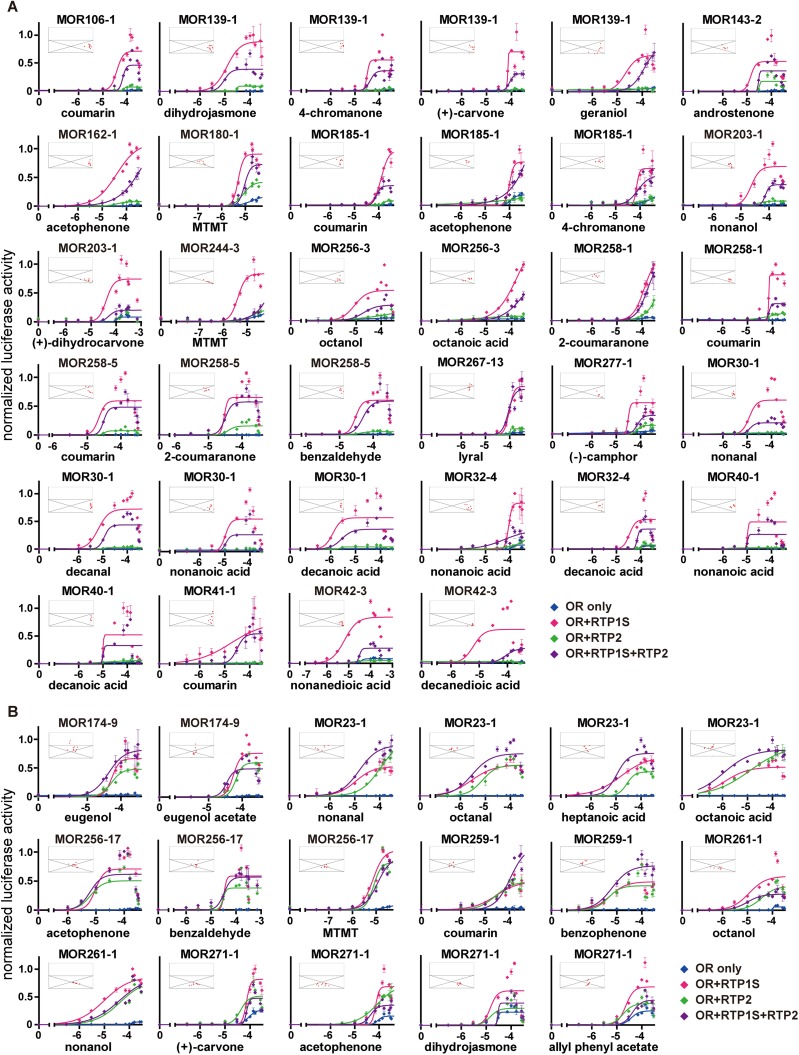
RTP1S and RTP2 differ in their abilities to promote the functional activation of ORs.(A-B) normalized luciferase activities of concentration gradients of 28 odorants from 0 μM to 30, 300 or 320 μM tested against 24 ORs with different combinations of RTPs co-transfected, including RTP1S (red), RTP2 (green), and a combination of the two (purple) in HEK293T cells. An “OR only” negative control is co-transfected with the empty pCI vector (blue). The x-axis represents molar odorant concentrations on a logarithmic scale. The y-axis represents normalized luciferase activity shown as mean ± S.E.M. (N = 3). The scatter diagrams (inset) depict the functional effect induced by the combination of RTP1S and RTP2 compared to RTP1S or RTP2 alone (Materials and methods and S1 Fig). The x-axis represents the value of the parameter τRTP1S, which represents the ratio of the OR response level when co-transfected with RTP1S to the algebraic sum of individual OR response levels when co-transfected with single RTPs. The y-axis represents the value of the parameter σ, with σ = 1 dividing the diagram into hyper-addition and hypo-addition sections. The responses at lower concentrations that did not elicit OR activation were not plotted.